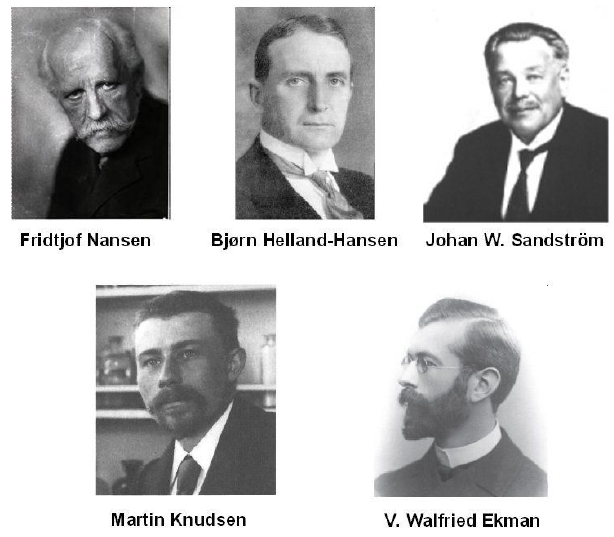
Fig. 24. Pictures of: Fridtjof Nansen, Bjørn Helland-Hansen, Jo- han W. Sandstr¨om, Martin Knudsen, and V. Walfrid Ekman. All images, except that of Martin Knudsen, have been obtained